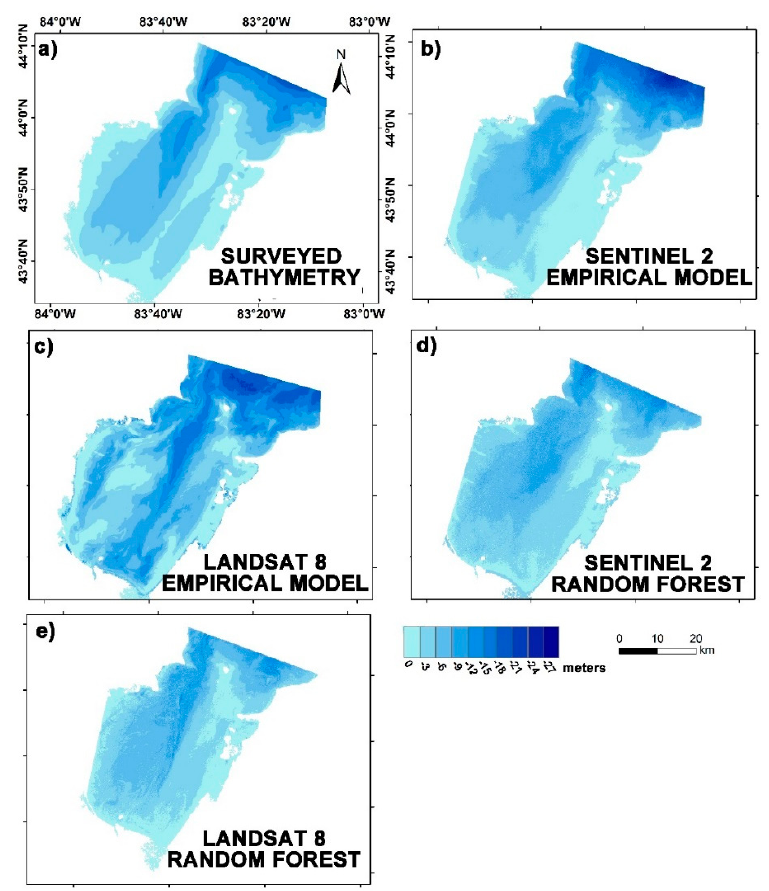
Figure 9. Bathymetric maps of Lake Huron: ( a ) surveyed bathymetry; ( b ) Sentinel-2 derived bathymetry from empirical approach; ( c ) Landsat-8 derived bathymetry from empirical approach; ( d ) Sentinel-2 derived bathymetry from random forest; ( e ) Landsat-8 derived bathymetry from random forest.